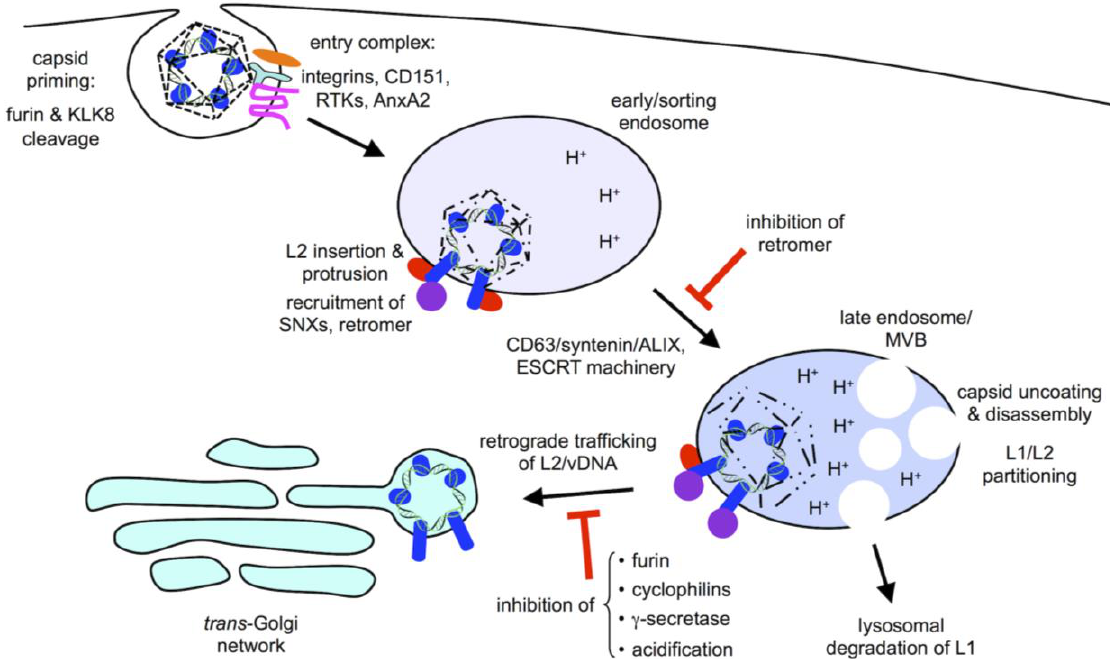
Figure 2. Early subcellular trafficking and uncoating. Internalized virions, primed by cleavage on the cell surface, enter the endolysosomal pathway and begin pH-dependent uncoating and L2 insertion/penetration. L2 recruitment of cytosolic sorting factors including sorting nexins (SNXs) and retromer modulates the trafficking pathway. Retromer binding is important for EE to LE/MVB transport. Retrograde transport of L2/vDNA from LE/MVBs to the trans -Golgi network (TGN) occurs in a furin-, cyclophilin- γ -sec-, and pH-dependent manner.